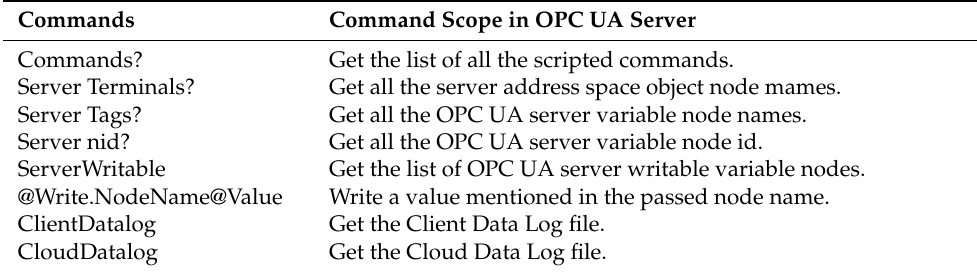
Table 4. List of command arguments scripted for the Telegram remote commander.